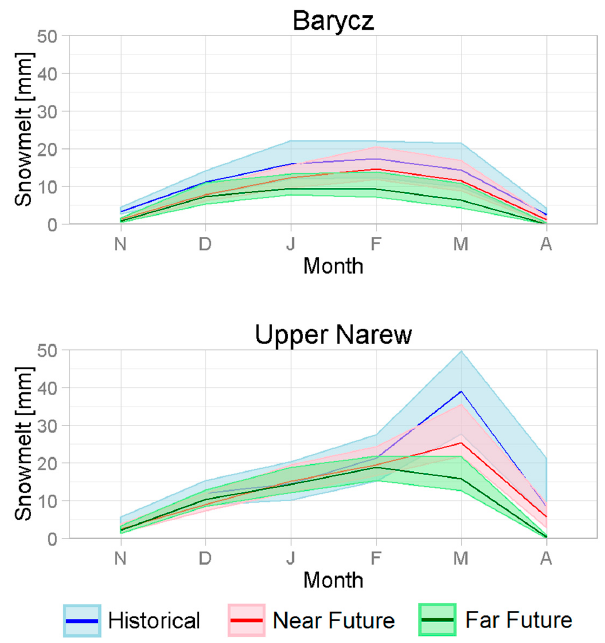
Figure 6. Multi-model ensemble projections of monthly snow melt (between November and April) for the near and the far future under RCP 4.5 in comparison to the historical